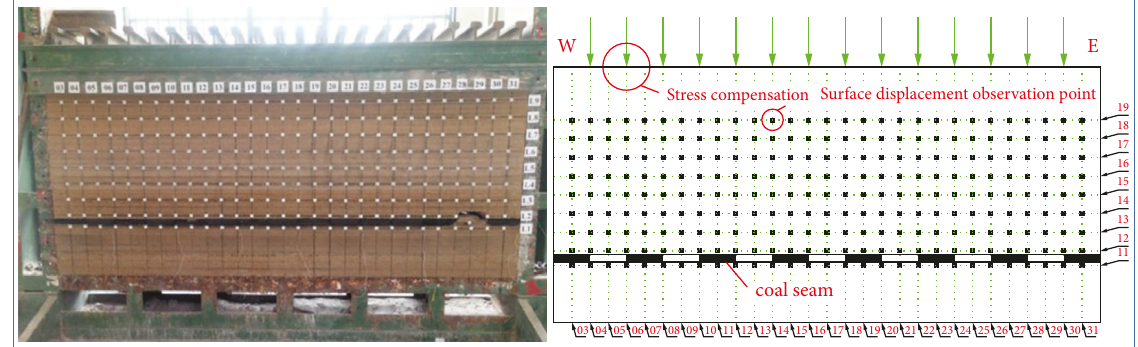
Figure 5: Surface displacement monitoring